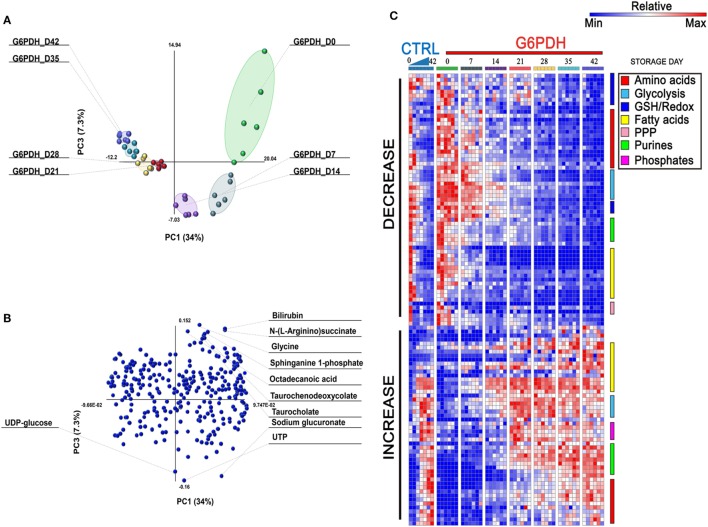
Multivariate analysis of metabolic phenotypes of stored red blood cells (RBCs) from glucose 6-phosphate dehydrogenase (G6PD)-deficient donors. Partial least square discriminant analysis [PLS-DA—panel (A)] revealed a U-shaped distribution of packed RBC samples from G6PD-deficient donors over storage in the blood bank, consistent with previous reports from Palsson’s lab (29, 30) and our group (9, 31). A loading plot for most significant variables informing the PLS-DA discrimination is shown in panel (B), and includes bioactive lipids and bile acids. In panel (C), a heat map of time course metabolic changes in RBCs from G6PD sufficient (median) or deficient (n = 6) donors, divided by pathway as specified by color codes in the top right corner of the panel.